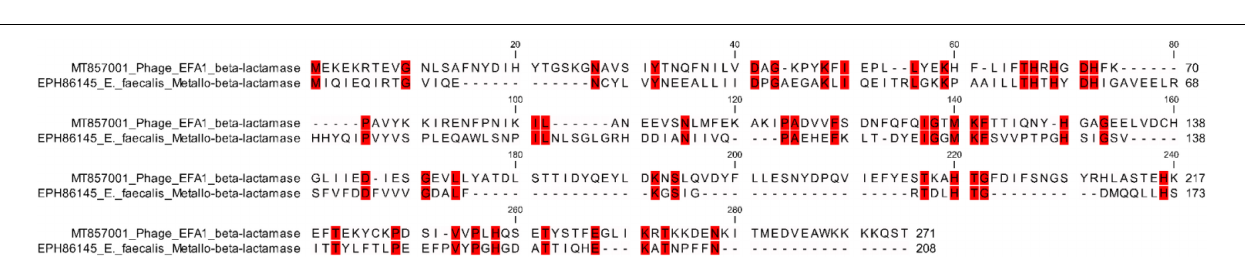
FIGURE 3 | Amino acid alignment of the E. faecalis beta-lactamase protein (EPH86145) with EFA1 bacteriophage putative beta-lactamase protein (ORF number 33). Red colored regions highlight areas of identical amino acids [47/272 (17.3%)] between the bacterial and bacteriophage putative beta-lactamase proteins, whereas the non-colored areas define regions where amino acids were